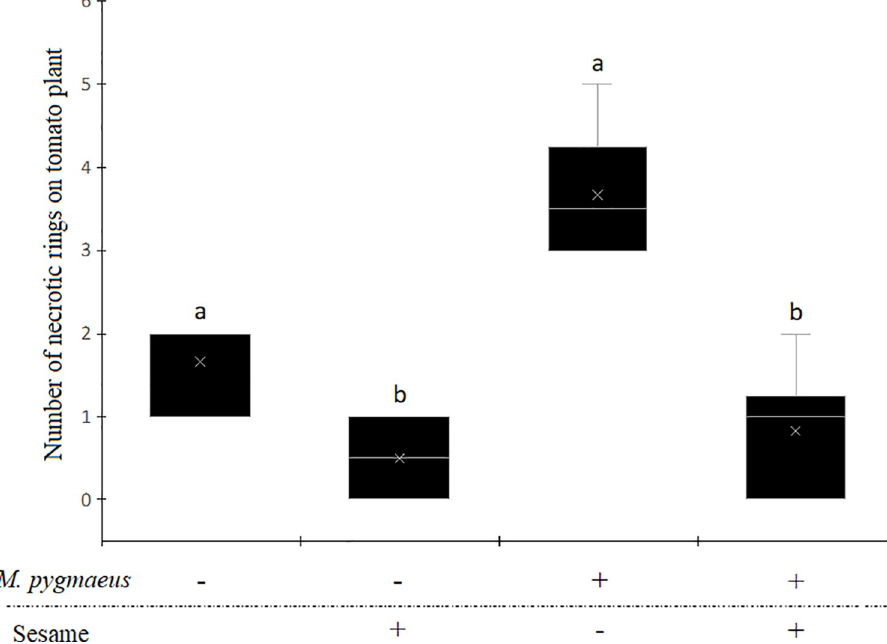
the ‘-’ indicates the absence. Boxplot followed by the same lower case letter did not differ significantly.